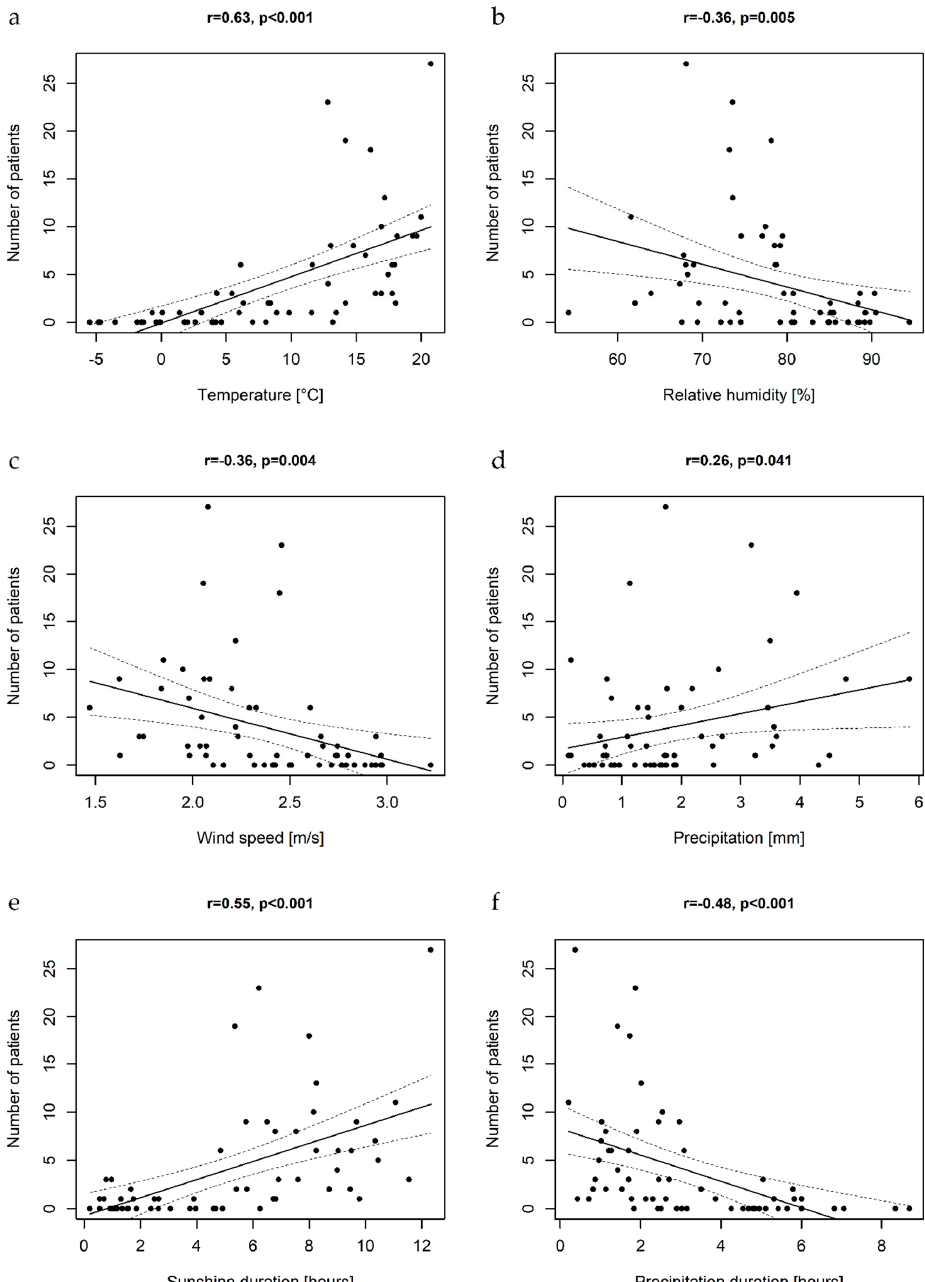
Figure 6. The scatterplots illustrating the associations between mean air temperatures ( a ), relative humidity ( b ), wind speed ( c ), precipitation rates ( d ), sunshine duration ( e ), precipitation duration ( f ), and monthly number of cases of pediatric EV central nervous system infections with the linear regression curves; r-Person’s correlation coefficient.